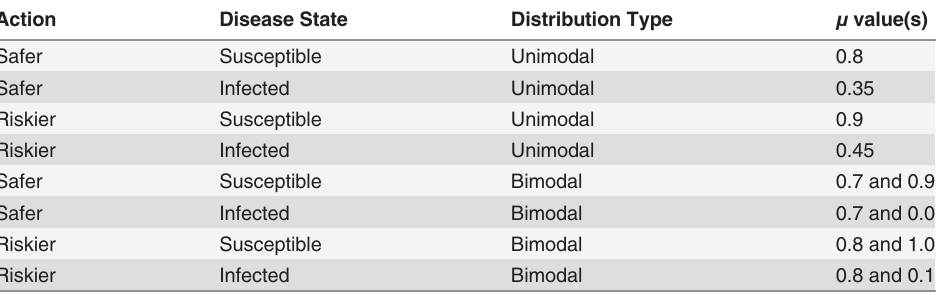
Table 2. Default values of μ used for unimodal and bimodal distributions of payoffs when simulating disease spread and behaviour in a generally uni fi ed industry as well as an industry composed of equal number of two types of holdings unequally effected by